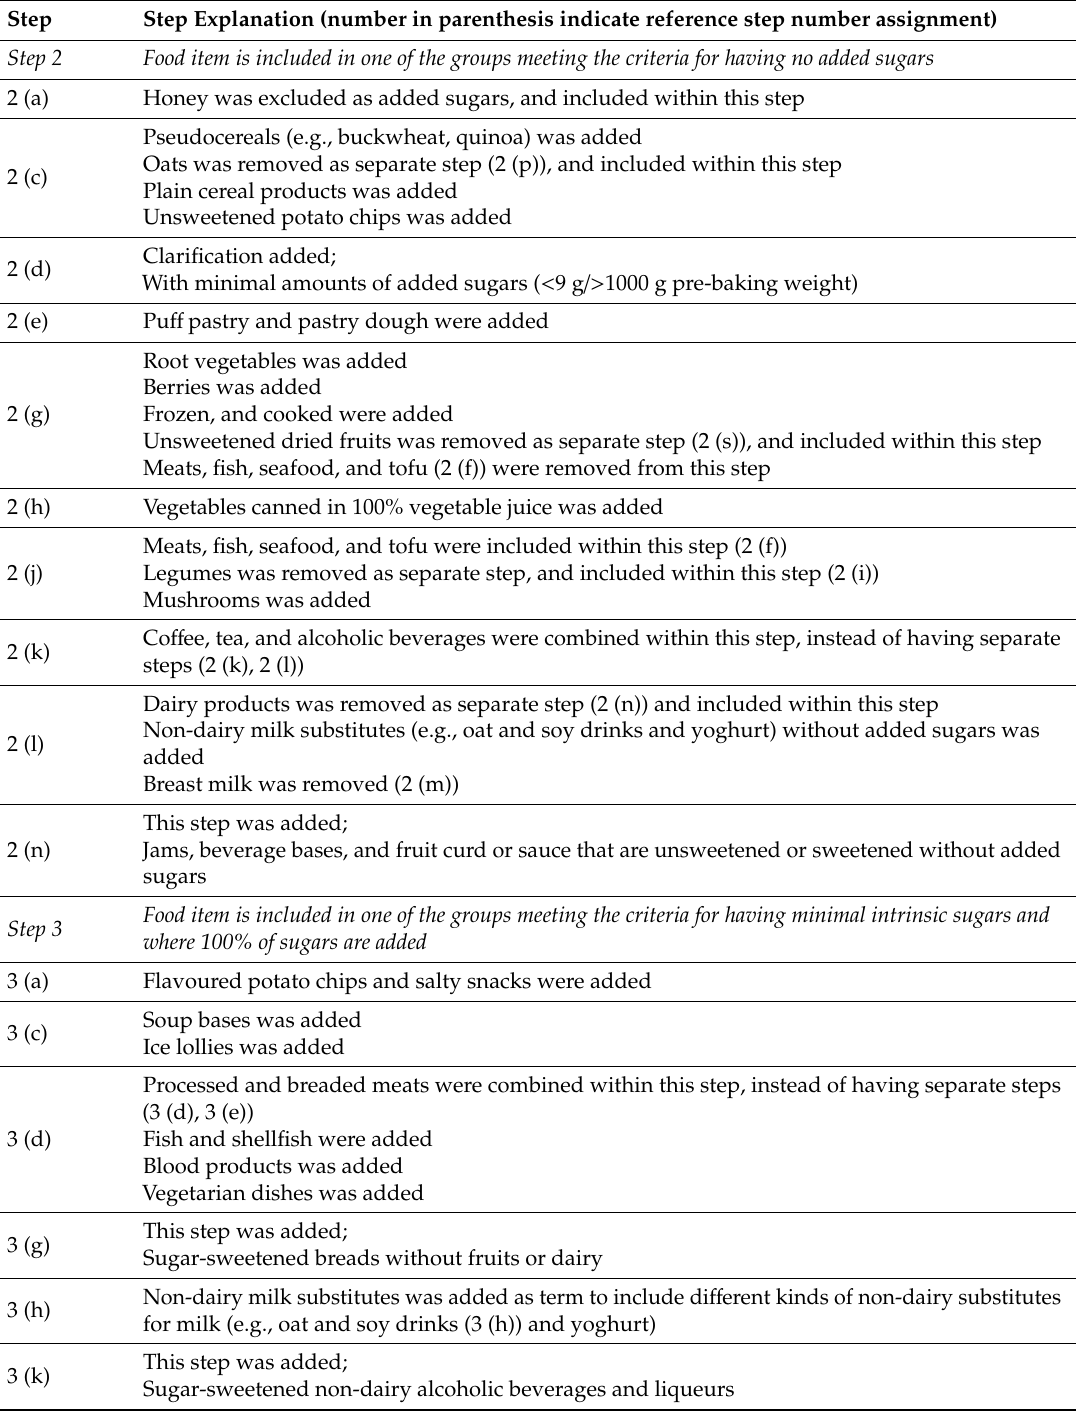
Table A2. Discrepancies in added and free sugars classification between our procedure and